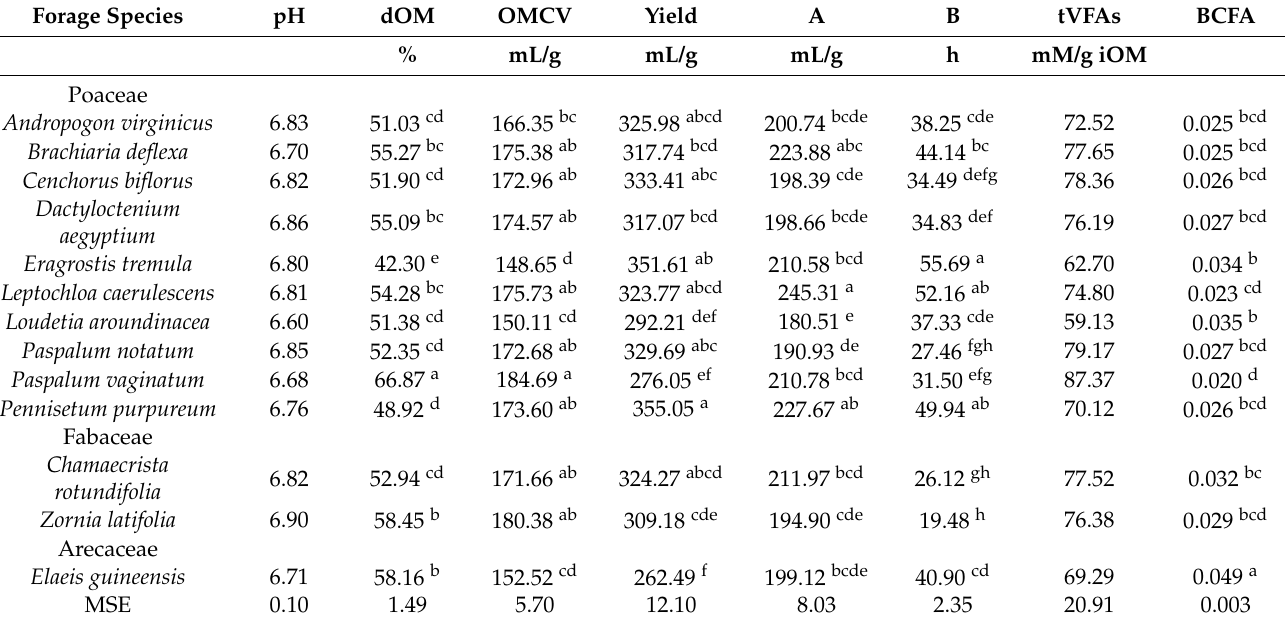
MSE: mean square error. Along the column, for each fodder, lower-case letters indicate statistically significant differences ( p < 0.01). dOM = organic matter degradability (% of incubated OM); OMCV = cumulative volume of gas related to incubated OM; Yield = cumulative volume of gas related to degraded OM; A = potential gas production; B = time at which A/2 was formed; BCFA: branched-chain fatty acid proportion on tVFAs; tVFAs: total volatile fatty acids. n = 39 corresponded to 13 forages × 03